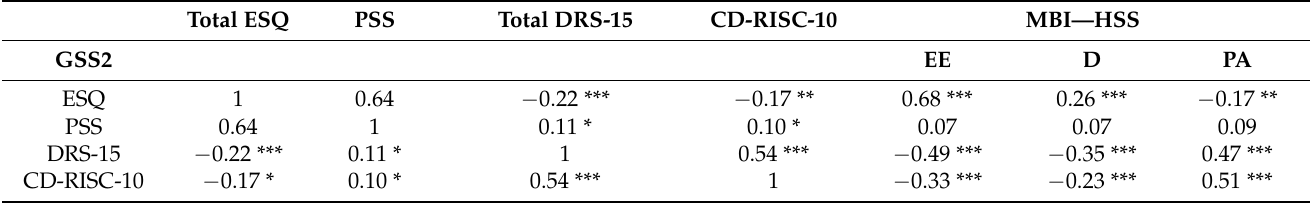
Table 4. Pearson’s correlations between total ESQ, PSS, DRS-15, CD-RISC-10, and MBI—HSS ( n = 260).